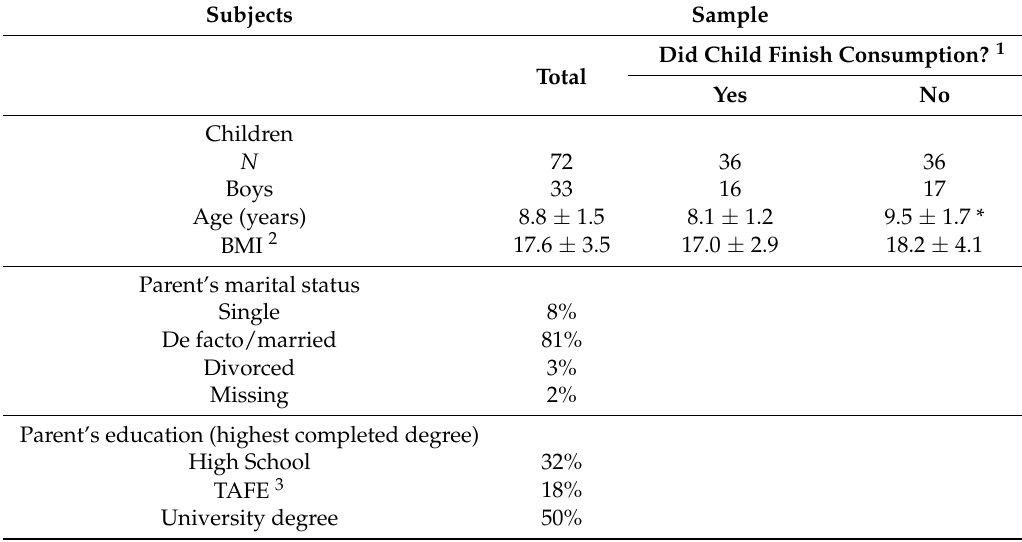
Table 1. Characteristics of the participants in the experiment.